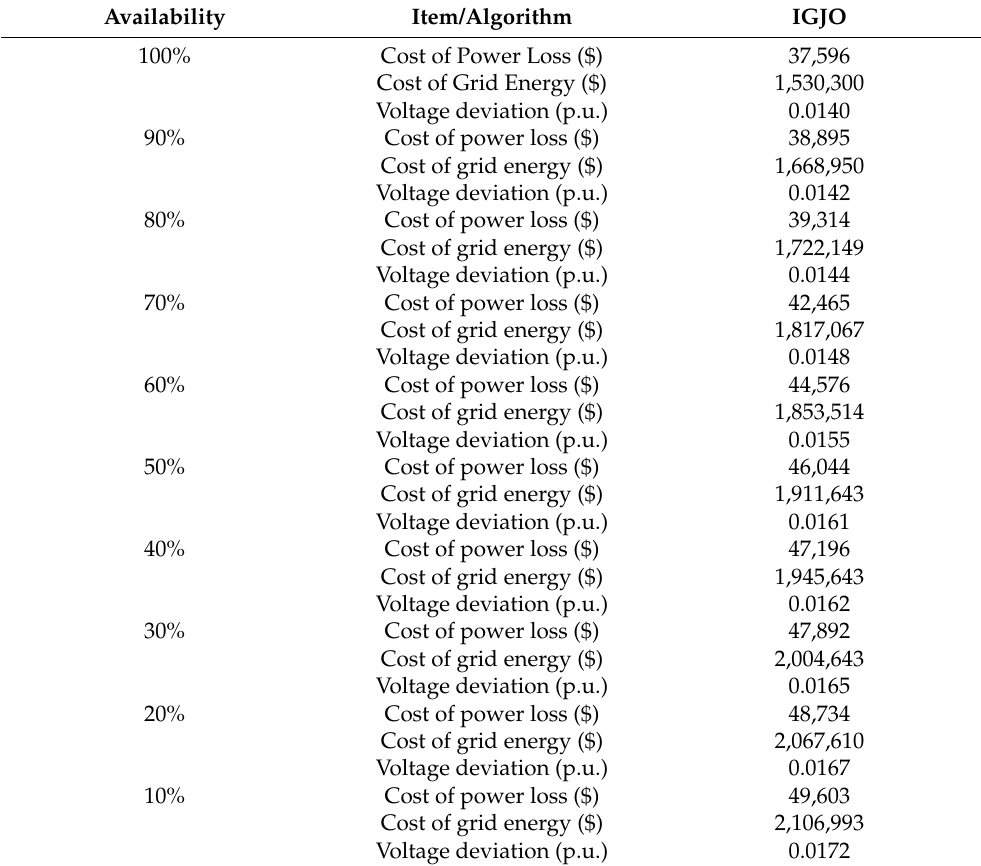
Table 8. The impact of PHEVs’ availability on costs of losses, grid energy, and voltage